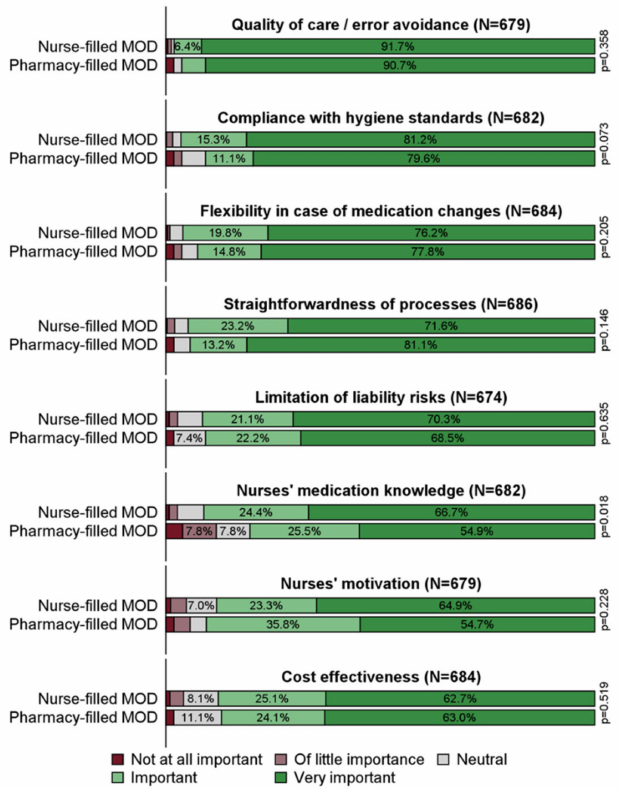
Figure 1. How important are the respective criteria when providing long-term medication? Answers by filling responsibility, N = number of valid answers for the respective item. MOD: medication organization